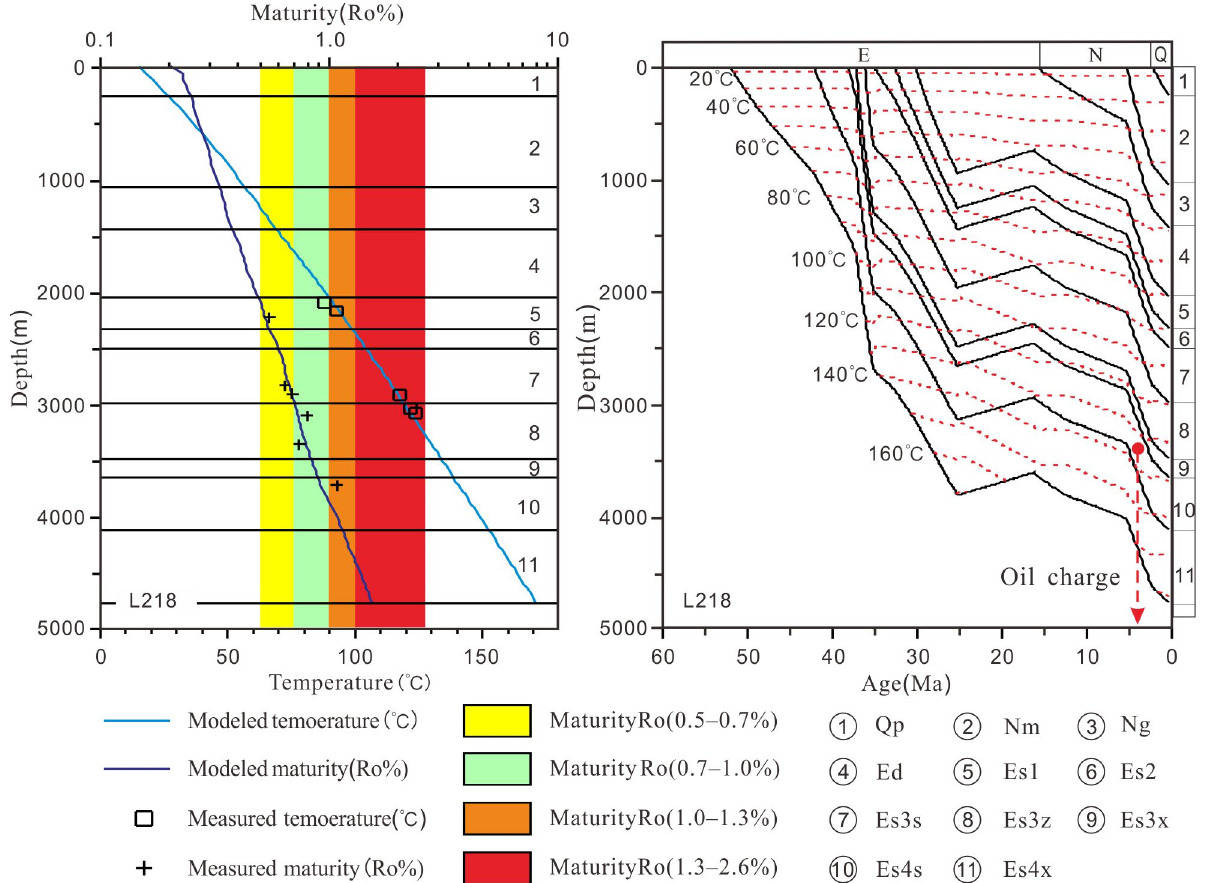
Figure 3. Burial–thermal evolution history of Well L218 and homogenization temperature projection of aqueous inclusions associated with oil inclusions.